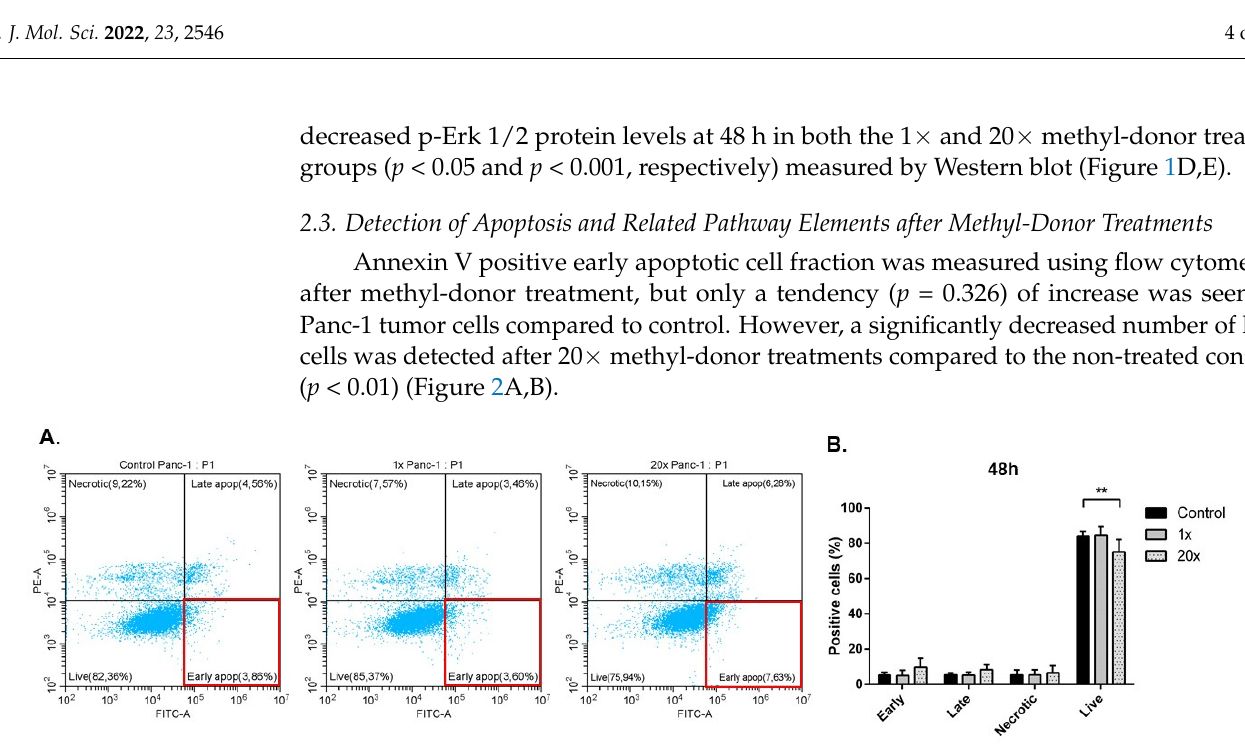
Figure 2. Detection of apoptosis in Panc-1 cell line. Early apoptotic cells (red-squared highlighted areas) did not change significantly; however, the number of live cells (lower left square) decreased significantly ( A , B ). Each bar represents the average percentage of positive cells in early apoptotic, late apoptotic, necrotic, and live cells area from at least 3 repeats ± SD. Statistical significance was plotted as **: p < 0.01. Early: early apoptotic cells; Late: late apoptotic cells; Necrotic: necrotic cells; Live: live cells. 1× and 20×: concentrations of methyl donors.